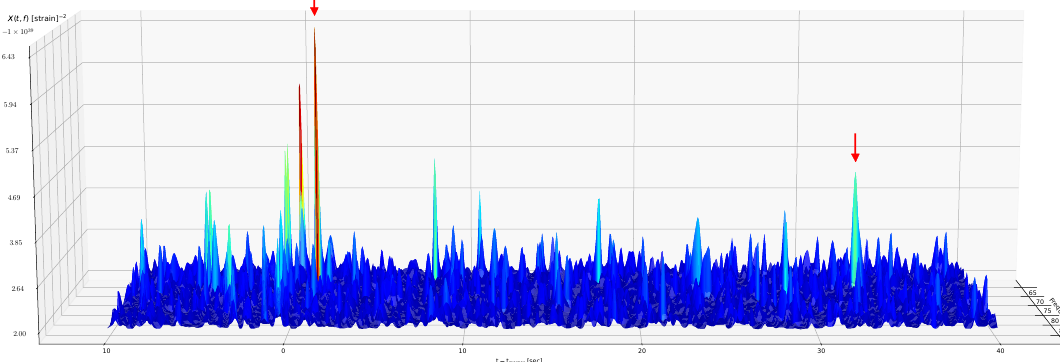
92 Hz [20]. − 0.5 ) Hz and t 1.0 s clearly t merger ± − (cid:39)